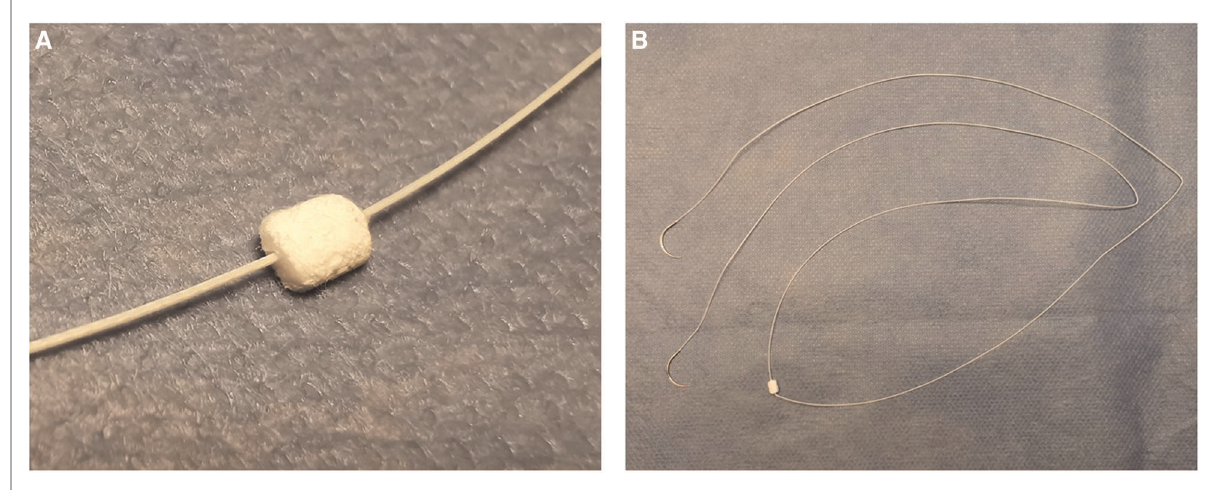
90 cm, with the pledget located in the middle of the suture. A 1/2 circle tapercut suture needle lies at each head of the suture (17 mm for AVR and 26 mm for MVR). The wire diameter of the polyester suture is 0.375 mm ± 0.025 mm and the diameter of the hole from which the sutures exit the pledget is 0.34 mm.